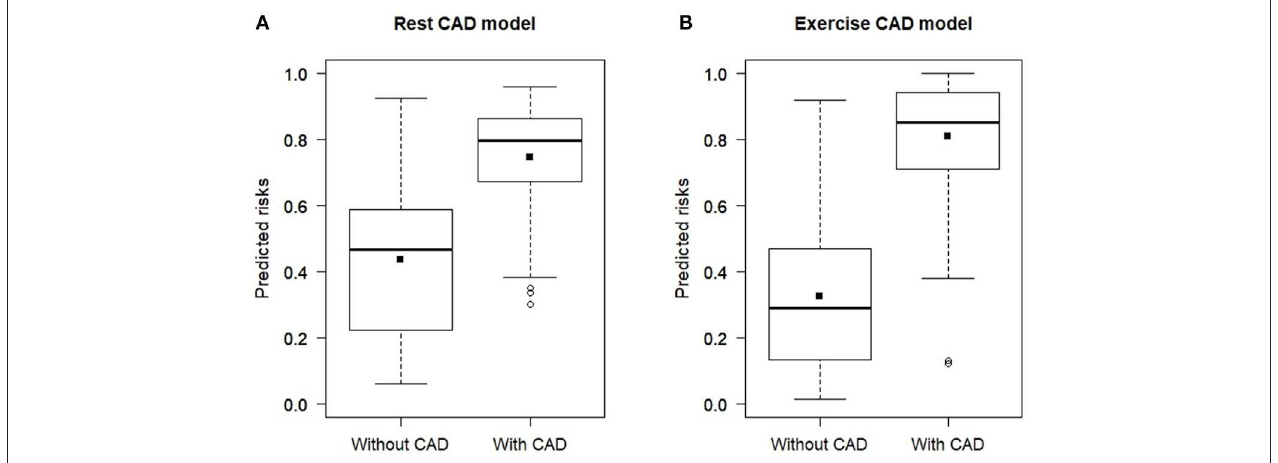
FIGURE 4 | Box plots of predicted risk of individuals with and without CAD estimated by (A) CAD rest and (B) CAD exrc . The discrimination slope, which is the difference between the mean predicted risk for individuals with and without CAD, was estimated as 0.3 using the CAD rest model and 0.5 using the CAD exrc model.